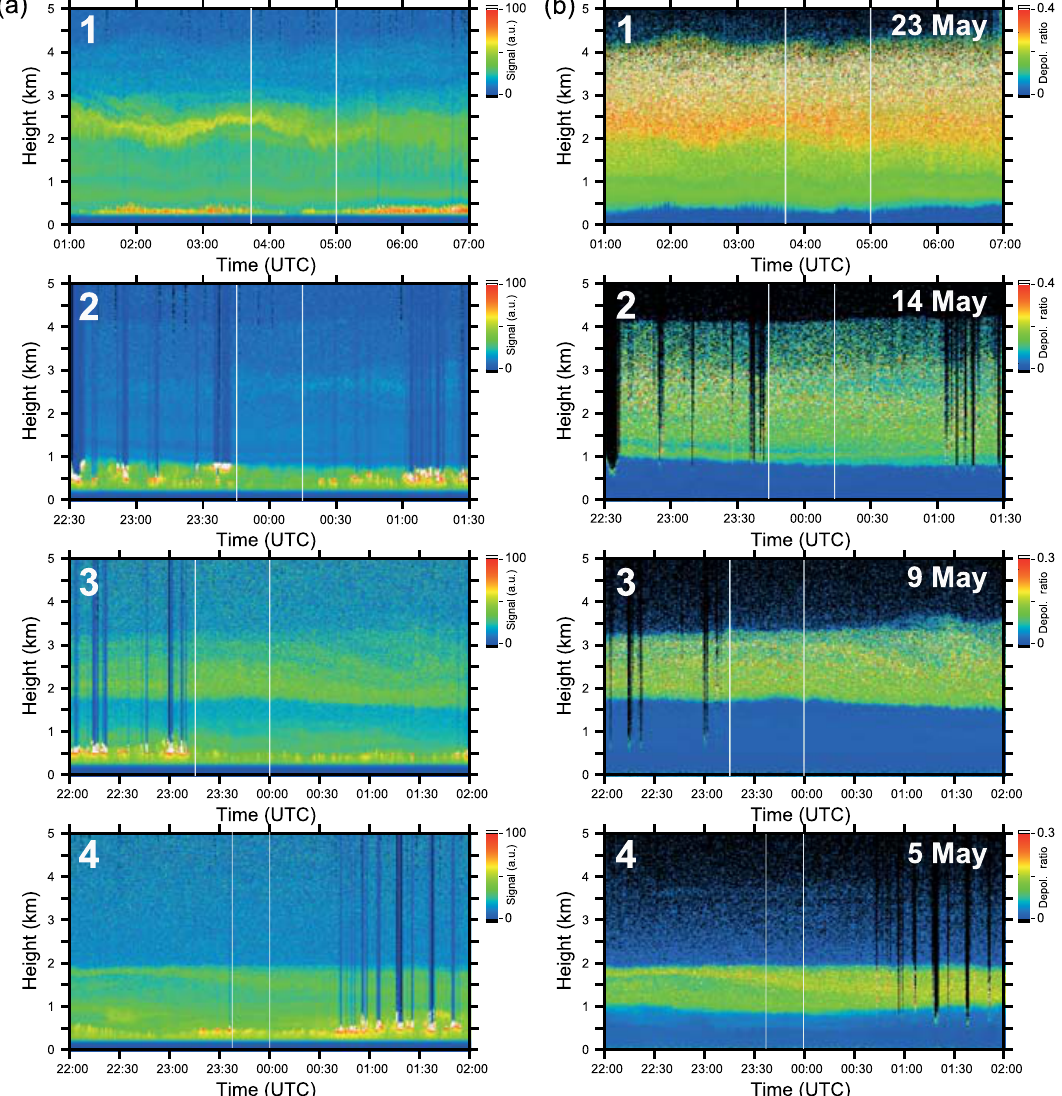
Figure 2. Marine and dust layers over the tropical Atlantic about 1000km (case 1), 1700km (case 2), 3300km (case 3), and 4300km (case 4) west of the African coast. The 532nm range-corrected signal (a) and 532nm volume linear depolarization ratio (b) are shown. Linear color scale is used. Temporal and vertical resolution are 30s and 7.5m, respectively. The SAL is on top of the MAL (low depolarization ratios displayed in blue in the b panels). White spots in the (a) panels (below 1km) indicate trade wind cumuli close to the top of the MBL, the convective part of the MAL. MBL top is at 400–500m (case 1), at about 1km (case 2), 600–900m (case 3), and 600–1000m (case 4). Vertical lines indicate the signal-averaging periods for which profiles of optical properties are discussed in Sect. 3.3. Lidar overlap effects (lowest 250m) prohibit a clear aerosol detection in the near range of the lidar in the (a) panels.